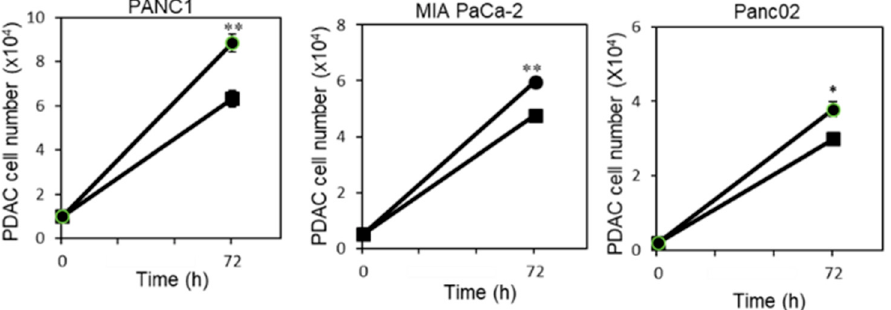
Figure 1. P. gingivalis infection enhances PDAC cell proliferation. PDAC cells (PANC1, MIA PaCa-2, and Panc02) were cultured in the absence of antibiotics alone or in the presence of P. gingivalis (MOI 10 bacteria per cell, 4 wells per condition) and cell number was calculated at the indicated time points (squares indicate cells without bacteria, and circles indicate cells with bacteria). One representative experiment of three is shown. Two-tailed t -test was performed for statistical analysis. * p ≤ 0.05, ** p ≤ 0.01.